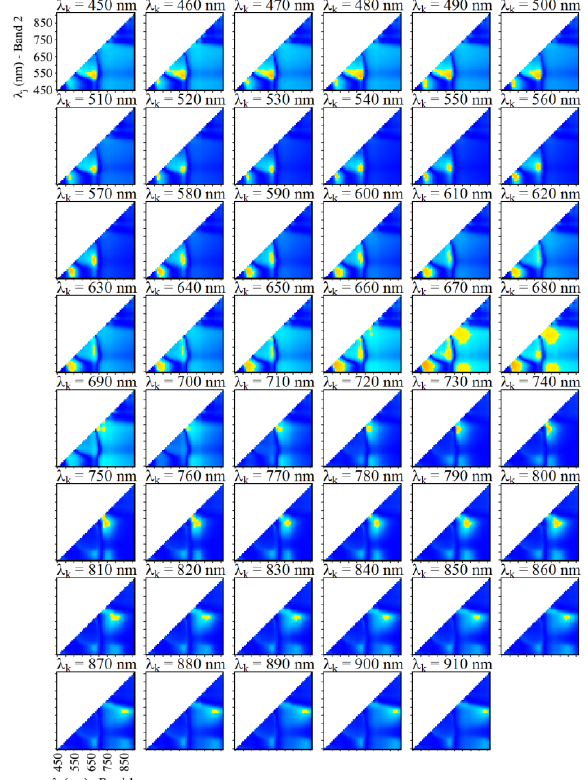
Figure 4. B-dist. for combinations of bands using DRI (same legend as Figure